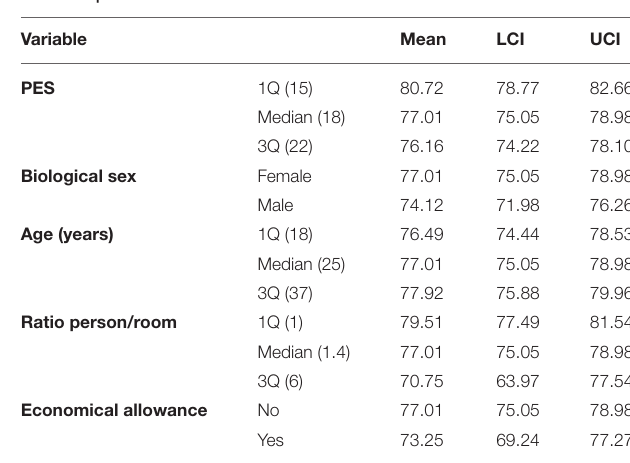
TABLE 2 | Predicted means of